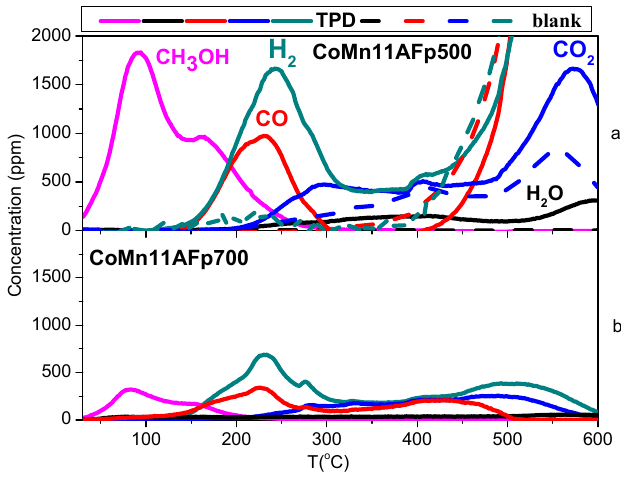
Figure 9. CH 3 OH ‐ TPD on CoMn11AFp500 and CoMn11AFp700.